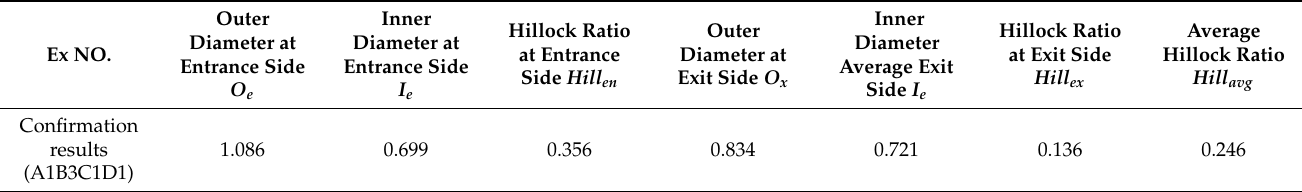
Table A6. Confirmation experimental results for average Hillock ratio.